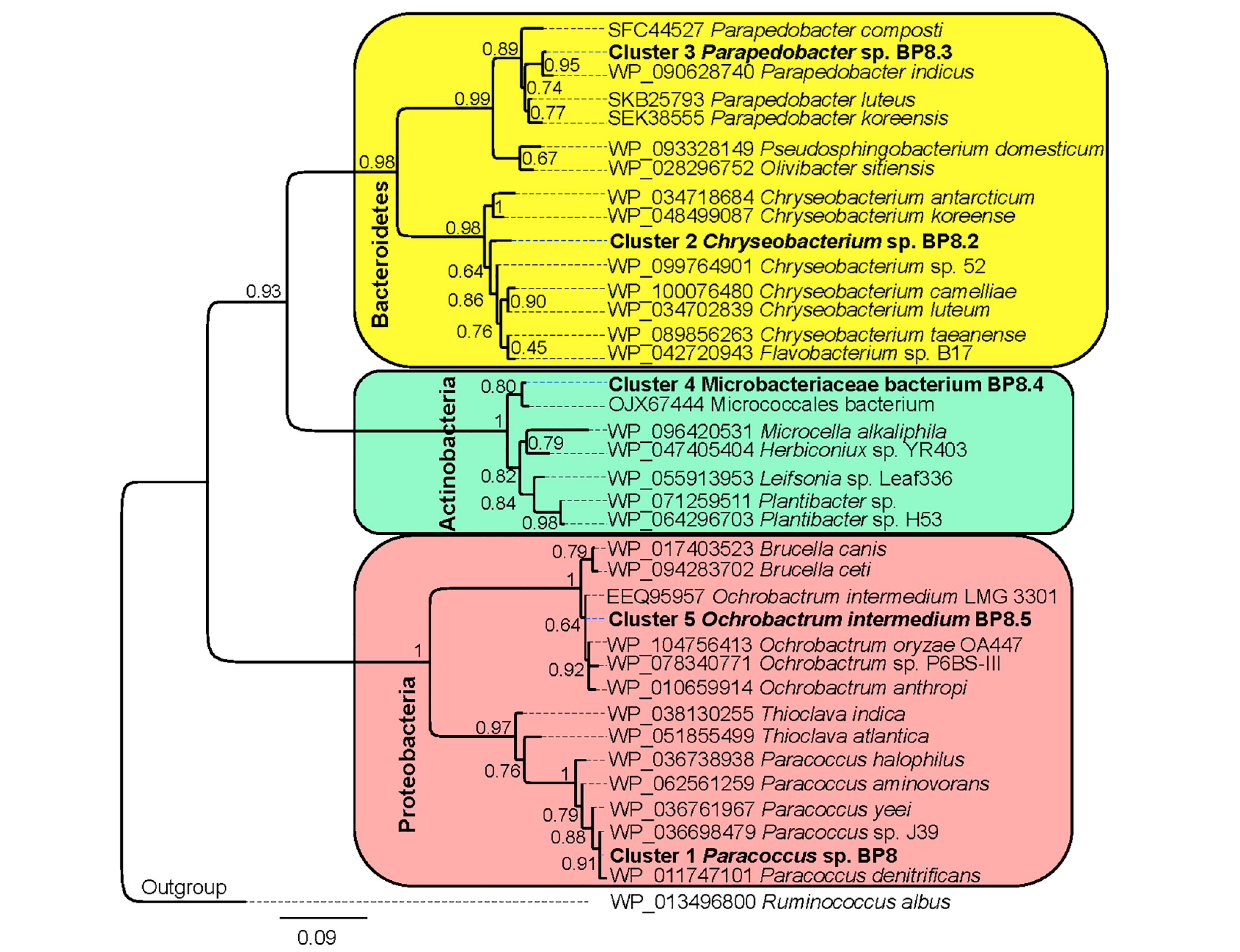
Frontiers in Microbiology |